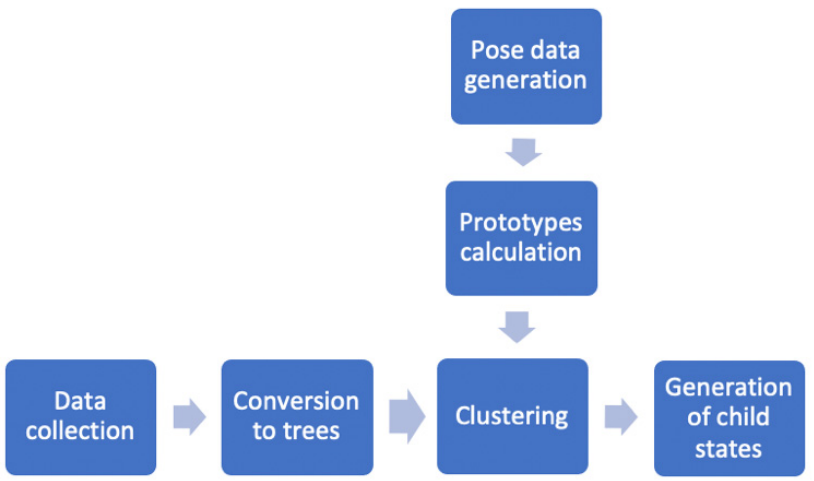
Figure 7. Process of determining the child states based on the collected data.